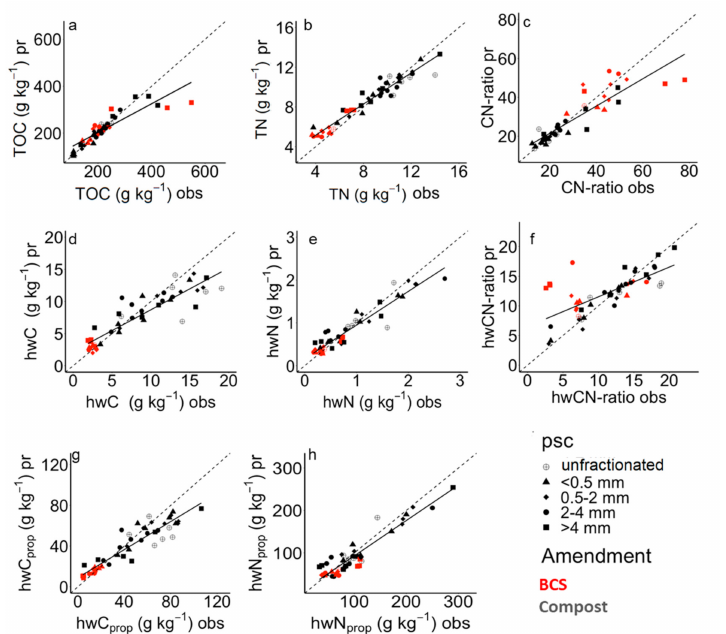
Figure 7. Test set validation SVM predicted (pr) and observed (obs) for ( a ) TOC, ( b ) TN, ( c ) CN-ratio, ( d ) hwC, ( e ) hwN, ( f ) hw-CN-ratio, ( g ) proportion of hwC to TOC (hwC prop ), and ( h ) proportion of hwN to TN (hwN prop ) in different OA size classes (pMIRS test set, n =